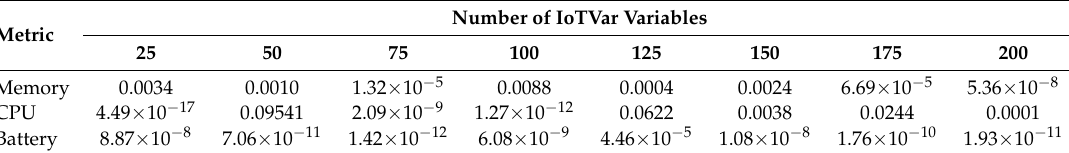
Table 2. p -values from the t -test for the publish-subscribe